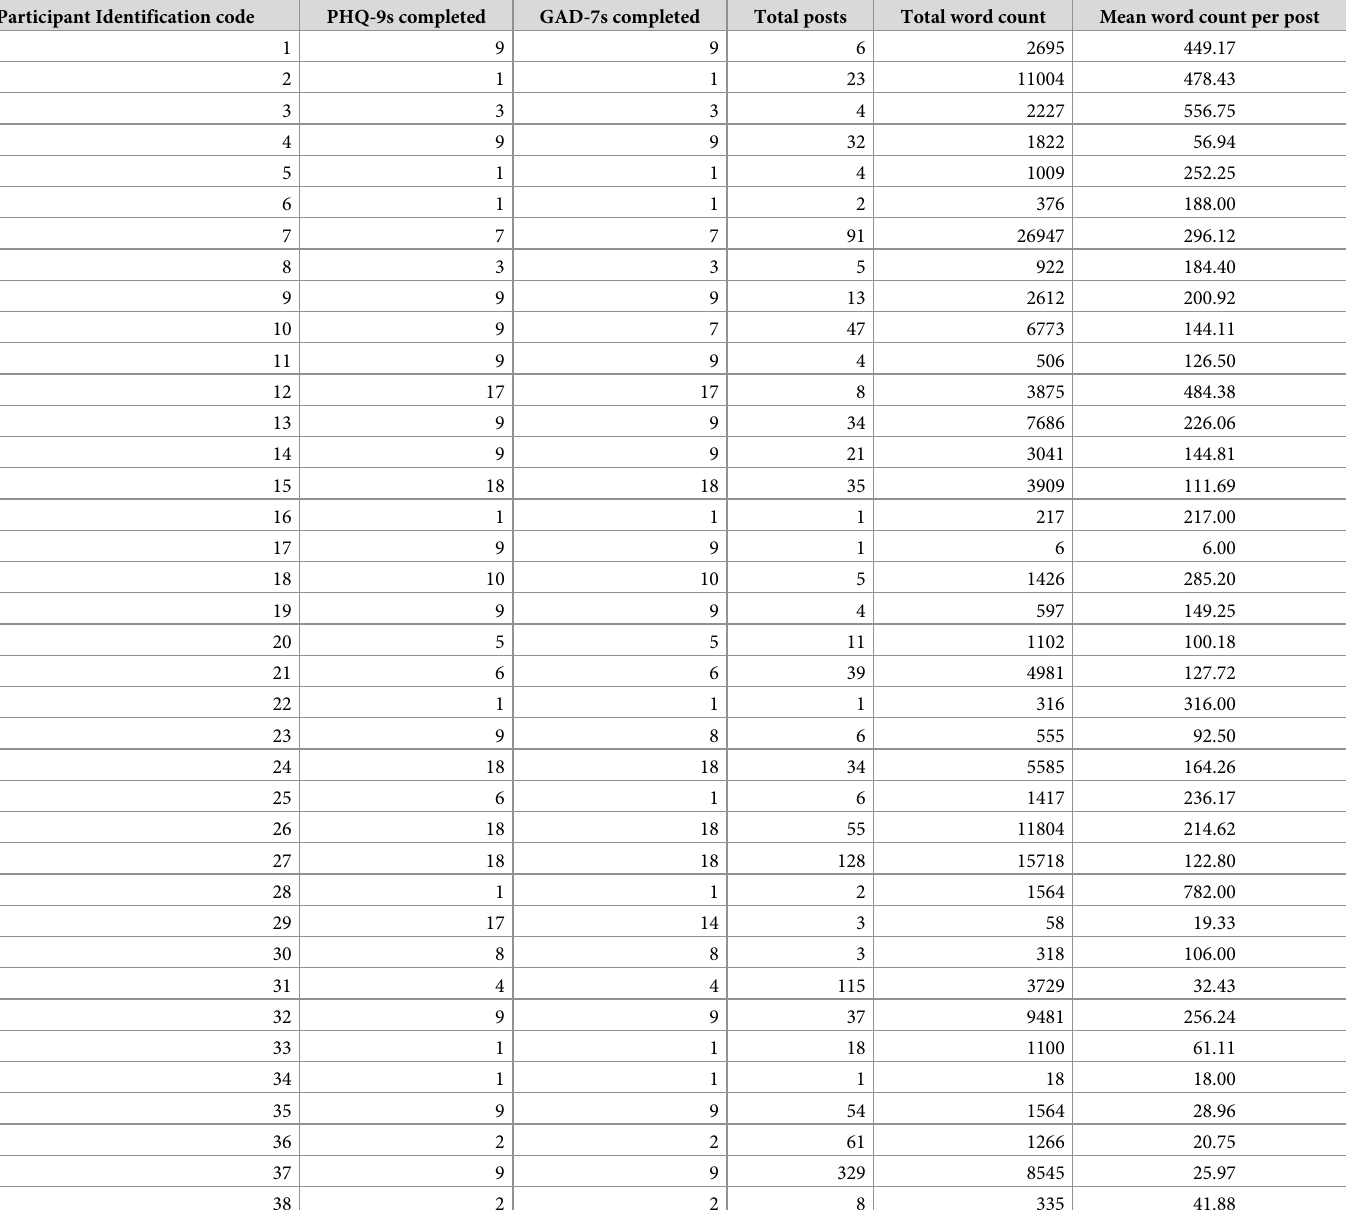
Table 2. Total number of surveys completed, blog posts, and word